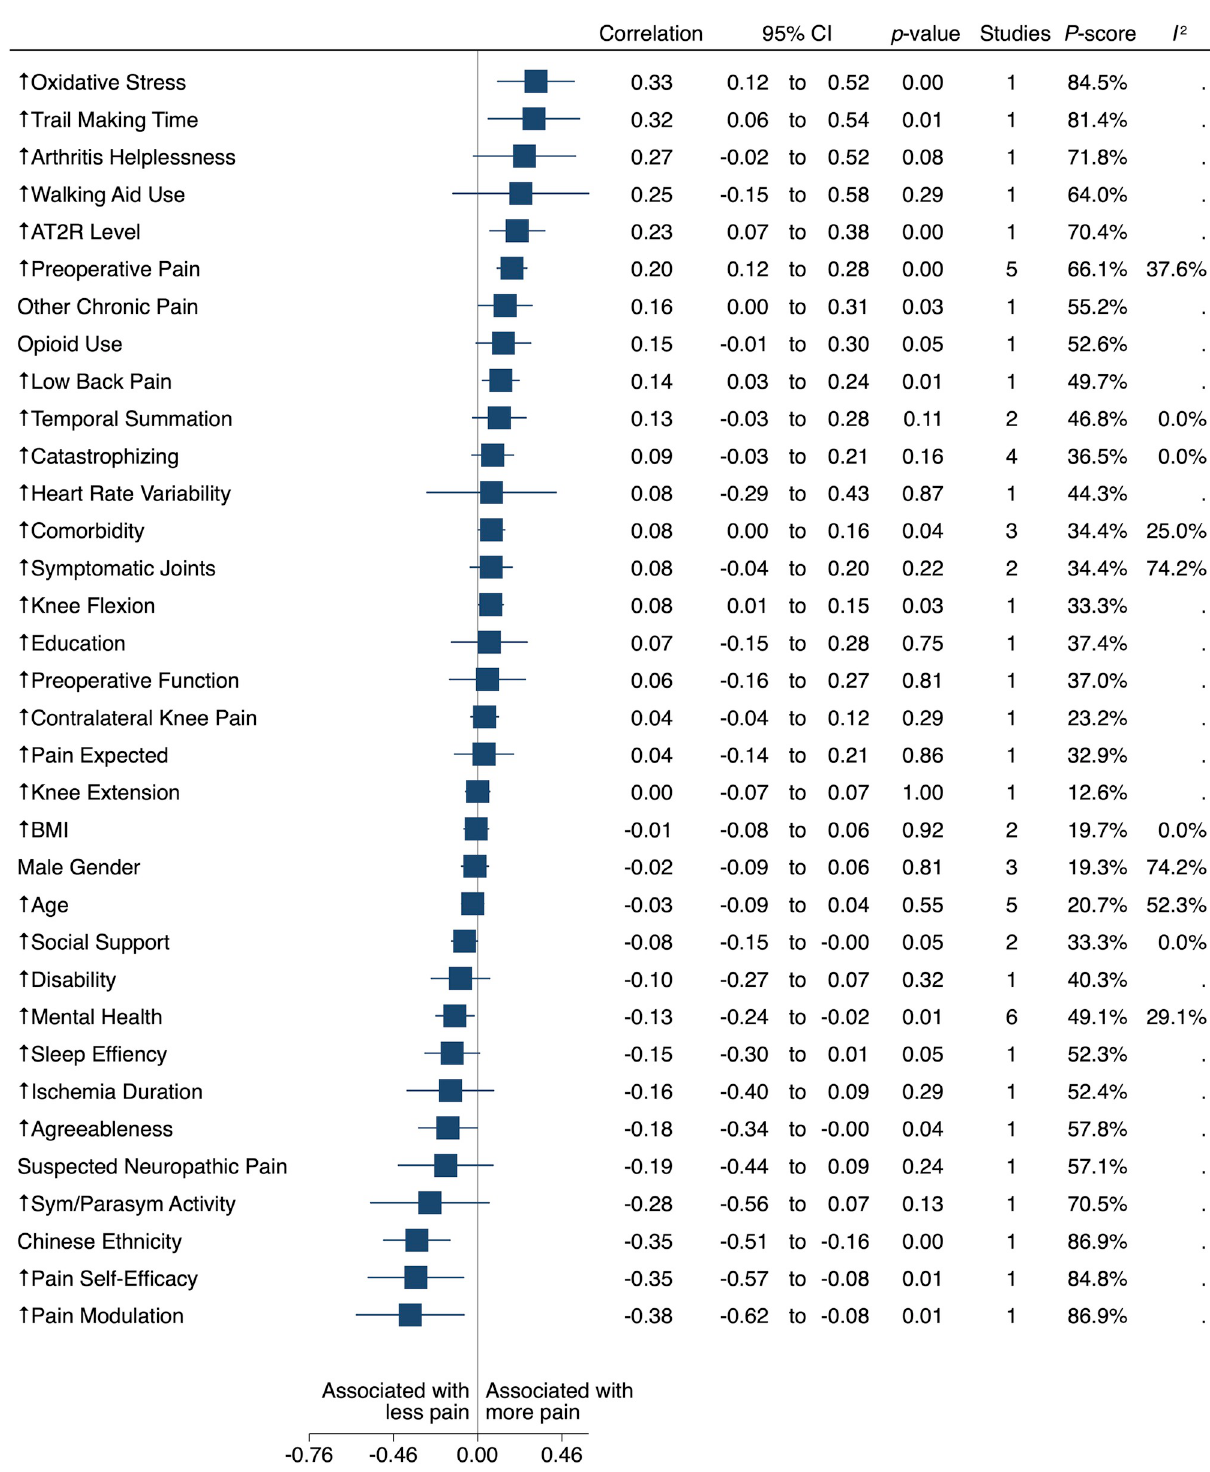
Fig 3. Forest plot of factors associated with pain at six months.